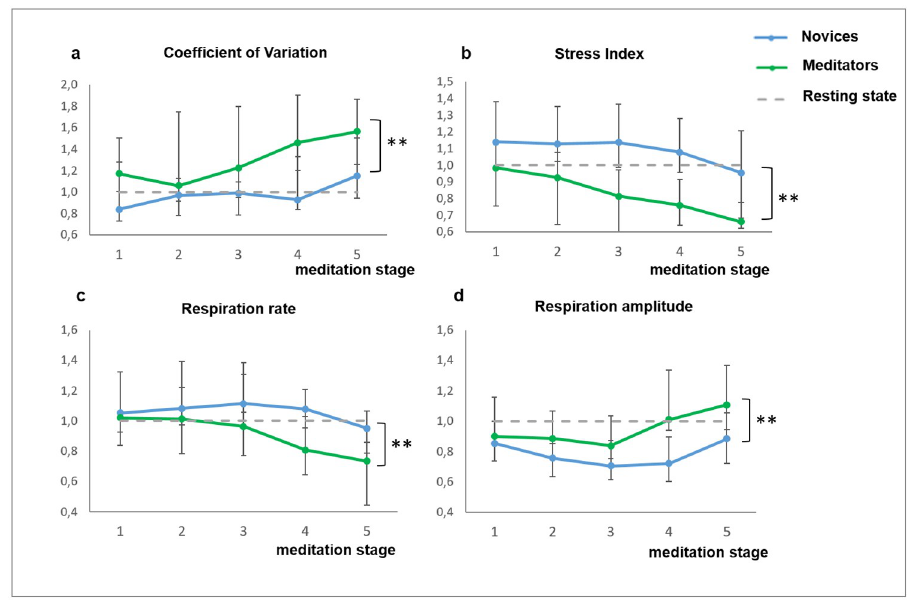
Fig 3. Changes of ANS activity markers in the experienced meditators (n = 13) and novices (n = 15). Data presented as Median ± IQR. �� —significant intergroup difference according to AN-test (p < 0.01). The dashed line reflects resting state reference